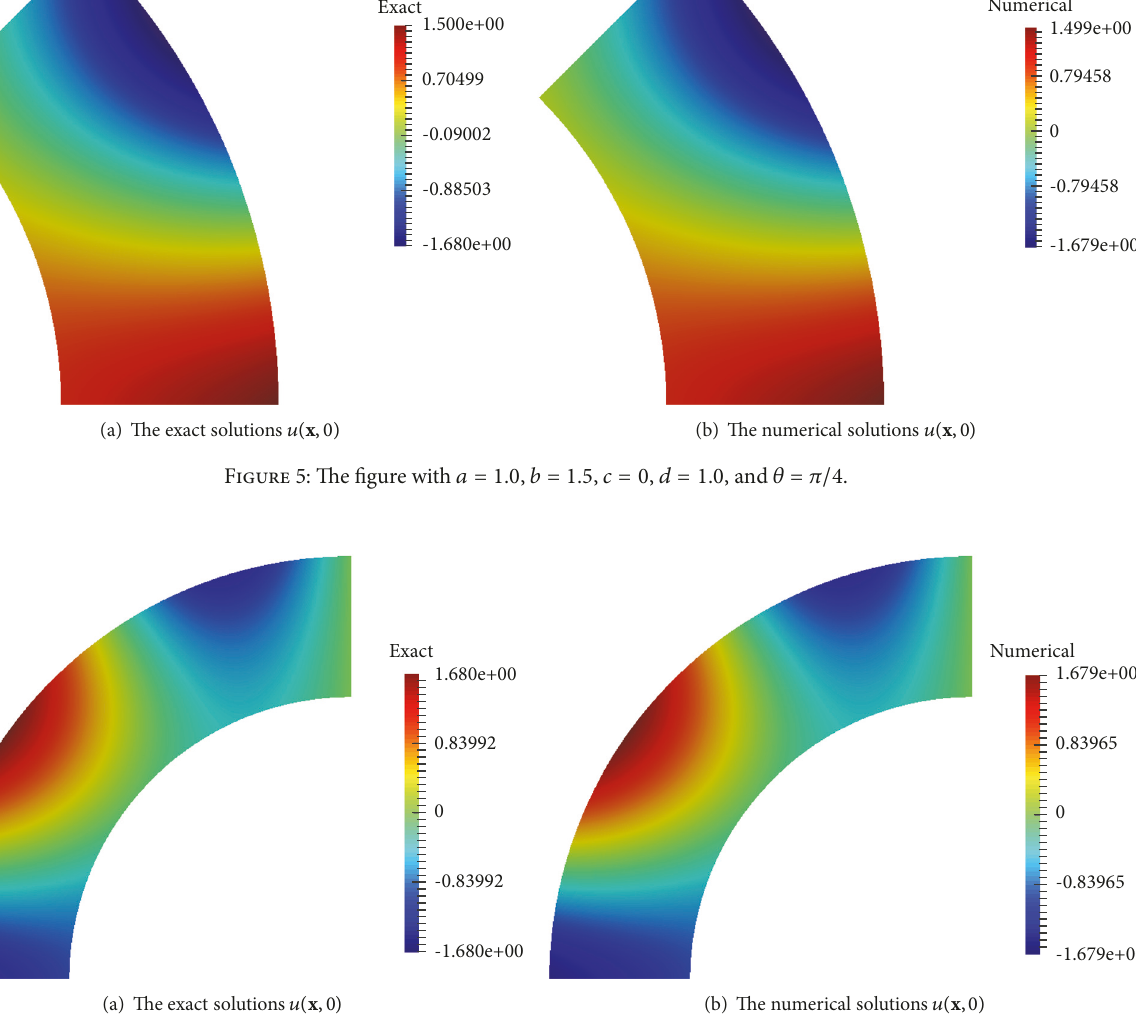
Figure 6: The figure with 𝑎 = 1.0 , 𝑏 = 1.5 , 𝑐 = 1.0 , 𝑑 = 2.0 , and 𝜃 = 𝜋/2